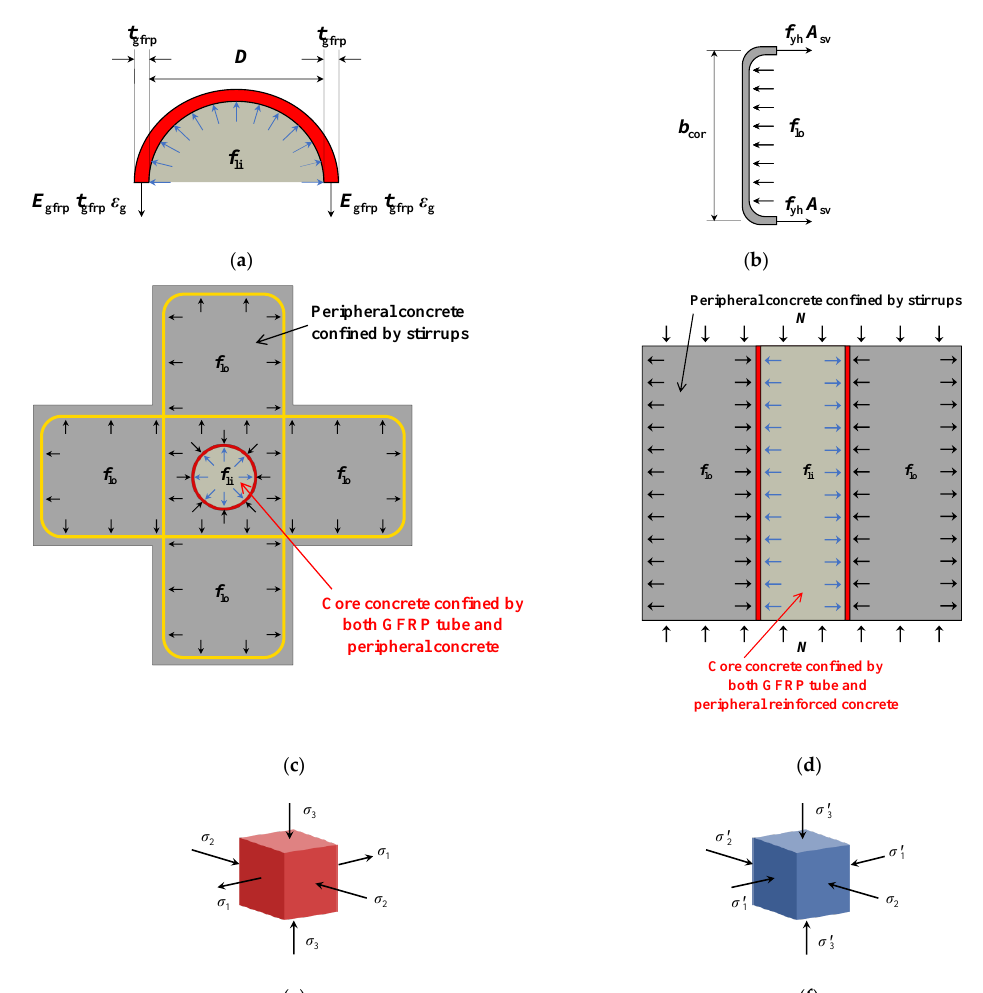
Figure 18. N - ε curves, K and µ of EGCSSCs with different α : ( a ) N - ε curves of specimens with cross-section height of 1000 mm. ( b ) K and µ of specimens with cross-section height of 1000 mm.